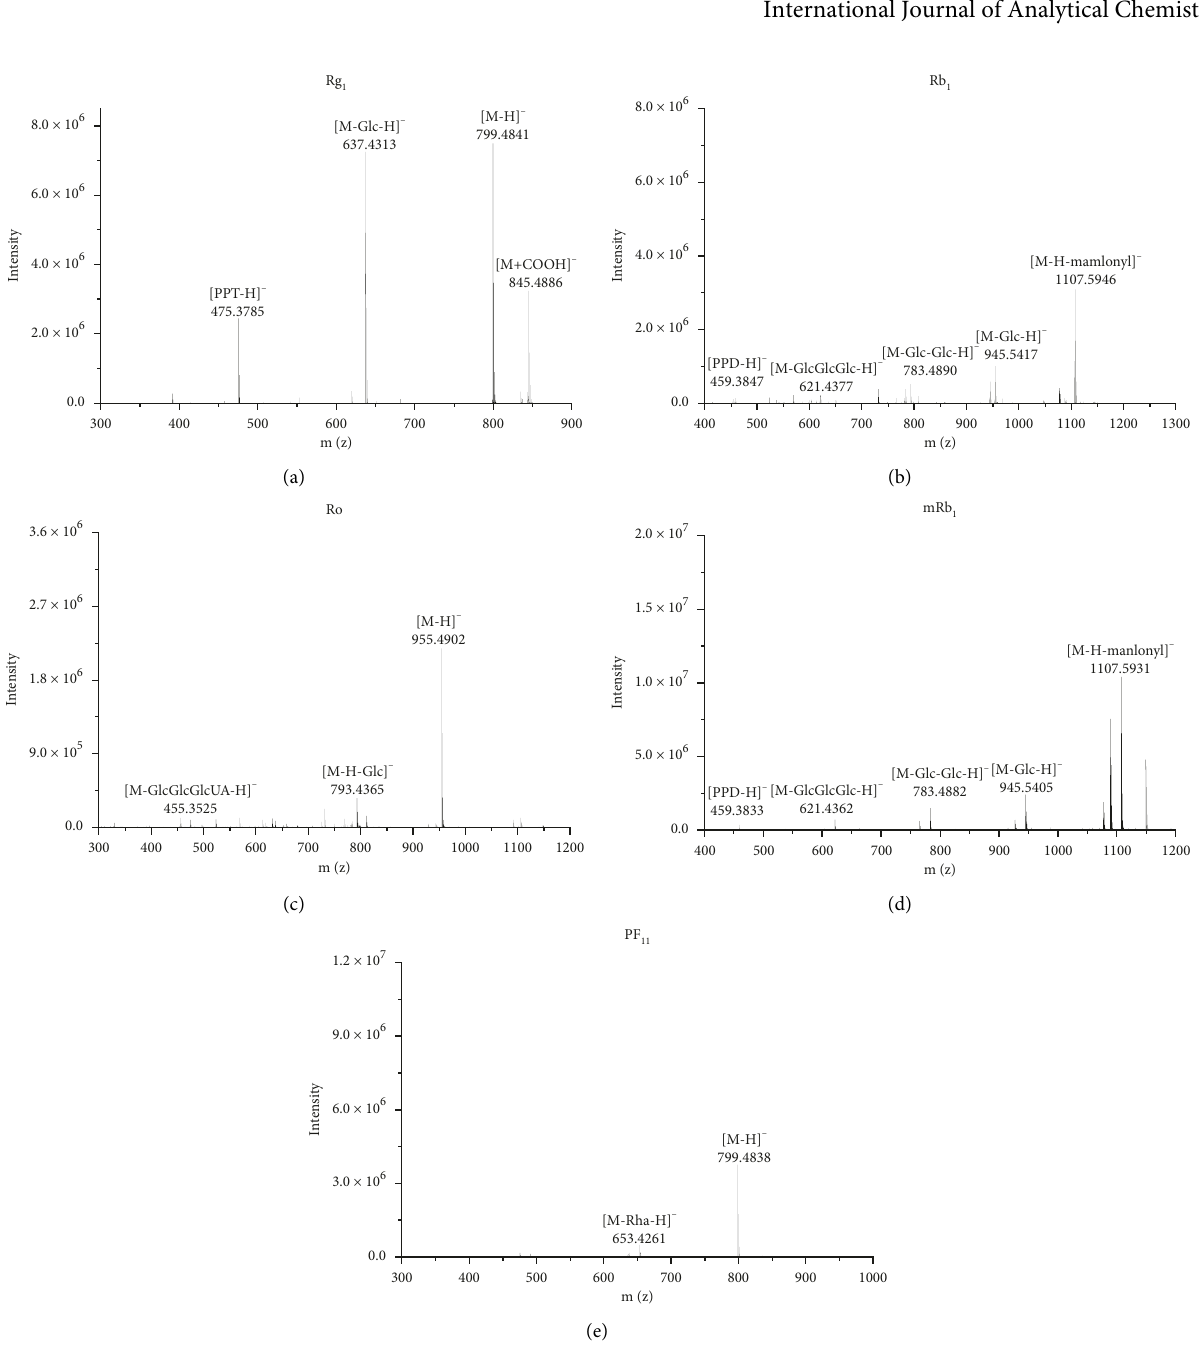
Figure 3: The MS/MS spectrum of ginsenosides in the negative ion mode: (a) Rg1; (b) Rb1; (c) Ro; (d) M-Rb1; (e)